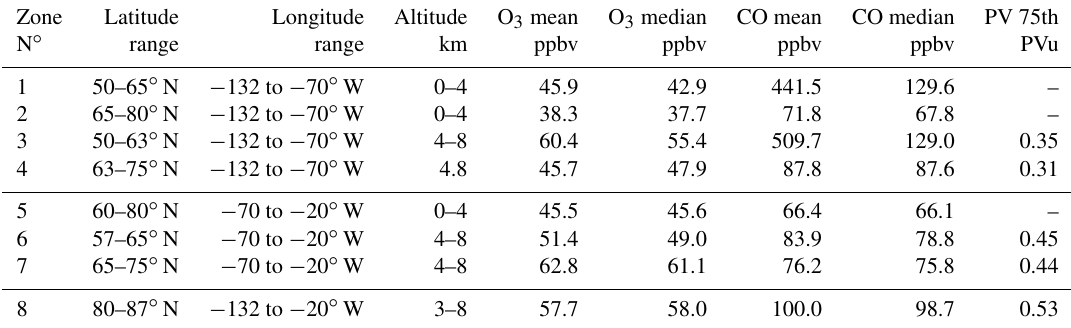
Table 4. Same as Table 3 for the WRF-Chem model O 3 , CO mixing ratio, and PV 75th percentile. Zone Latitude Longitude Altitude